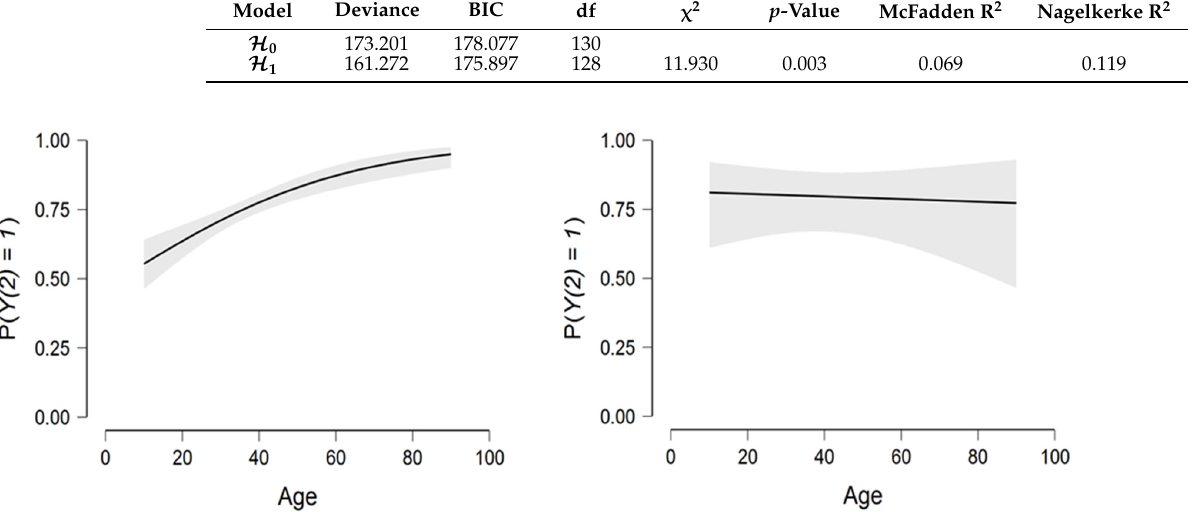
Figure 3. The relationship between age and the dependent variable Y 2 in both models.